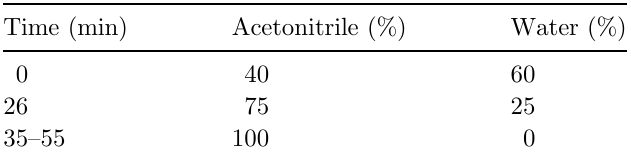
Table 1. Analytical gradient conditions.